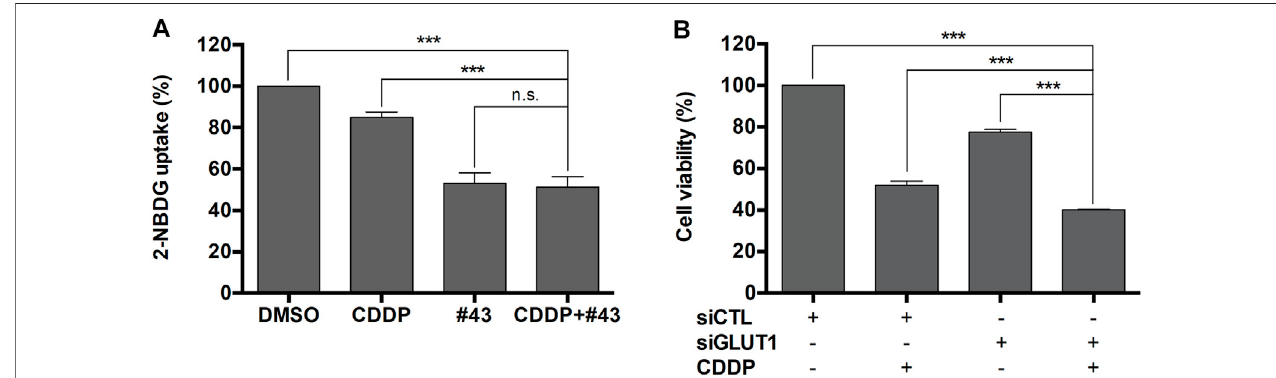
FIGURE 2 | Inhibition of glucose uptake by #43 in MCF-7 cells. (A) Quantitative results of 2-NBDG uptake assay. Cells were treated with 20 μ M cisplatin and/or 20 μ M #43 in PBS along with 200 μ M 2-NBDG for 1.5 h, and subjected to fl ow cytometric analysis. 2-NBDG uptake was calculated from the geomean of 2-NBDG fl uorescence in the treated group relative to the DMSO vehicle control. (B) Knockdown of GLUT1 enhanced the growth inhibitory effect of cisplatin. MCF-7 cells were transfectedwithscrambledsiRNA(siCTL)or GLUT1 siRNA(siGLUT1),andthentreatedwith10 μ Mcisplatinfor72 h.CellviabilitywasmeasuredbytheMTTassay. Data are presented as mean ± SEM of at least three independent experiments. ***, p < 0.001; n. s., not signi fi cant ( p > 0.05) by one-way ANOVA followed by Bonferroni t